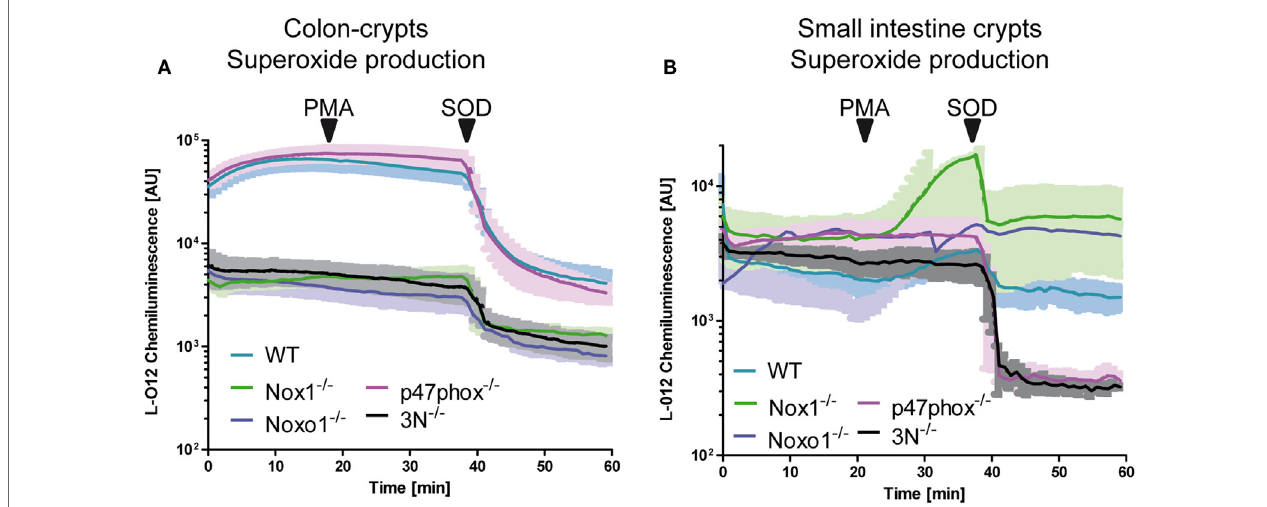
FigUre 2 | NoxO1-dependent reactive oxygen species (ROS) formation in colon crypts. A + B Crypts from colon (a) or small intestine (B) were isolated. ROS were measured by chemiluminescence with L-012 (200 μ mol/L). Activation of p47phox was triggered by phorbol myristate acetate (PMA, 100 nmol/L). Superoxide anions were decomposed with superoxide dismutase (SOD, 300 U/mL); n =